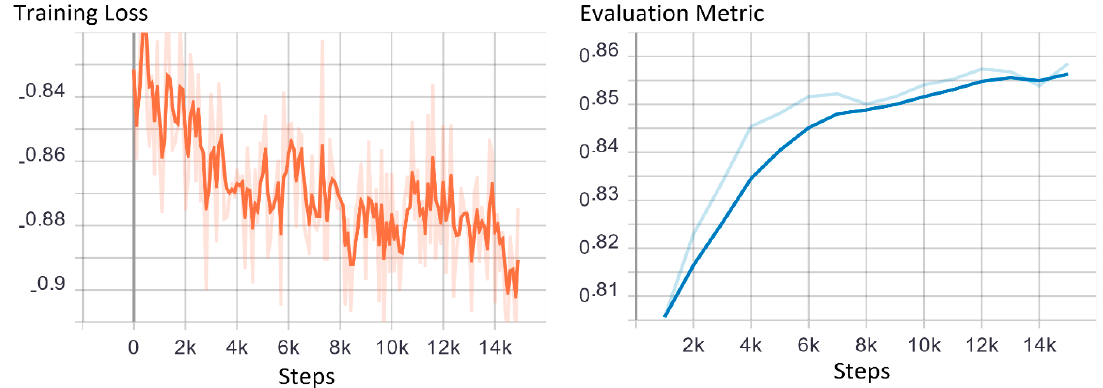
Figure 13. Training results of the TF-Ranking model using the generated dataset.